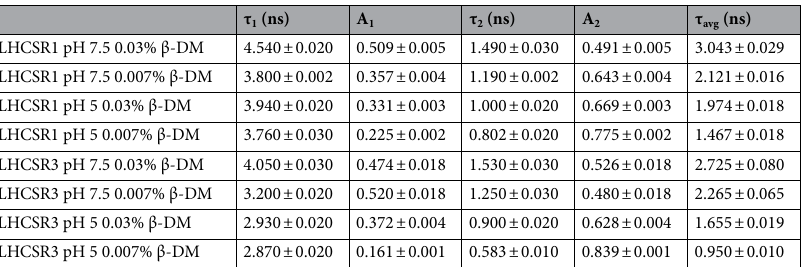
Table 2. Exponential fitting results of time-resolved fluorescence decay kinetics. Fluorescence kinetics reported in Fig. 5 were fitted with two exponential functions: decay constants (τ 1−2 ) and amplitude (A 1−2 ) of each component are reported in the table. Average fluorescence lifetimes were calculated as ΣA i τ i /ΣA i . Errors are reported as standard deviation (n =